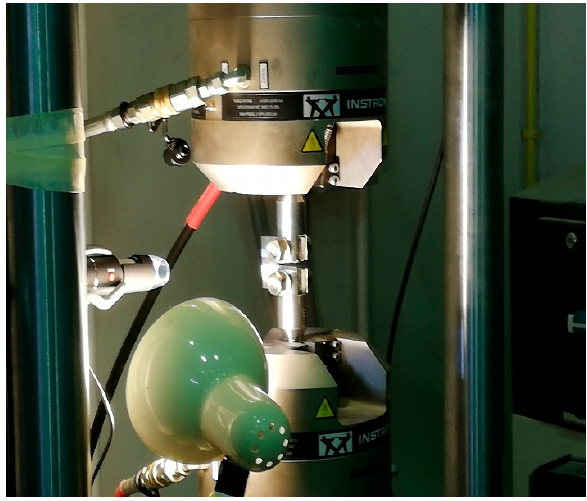
Figure 5. Fracture toughness testing setup on an Instron 8801.